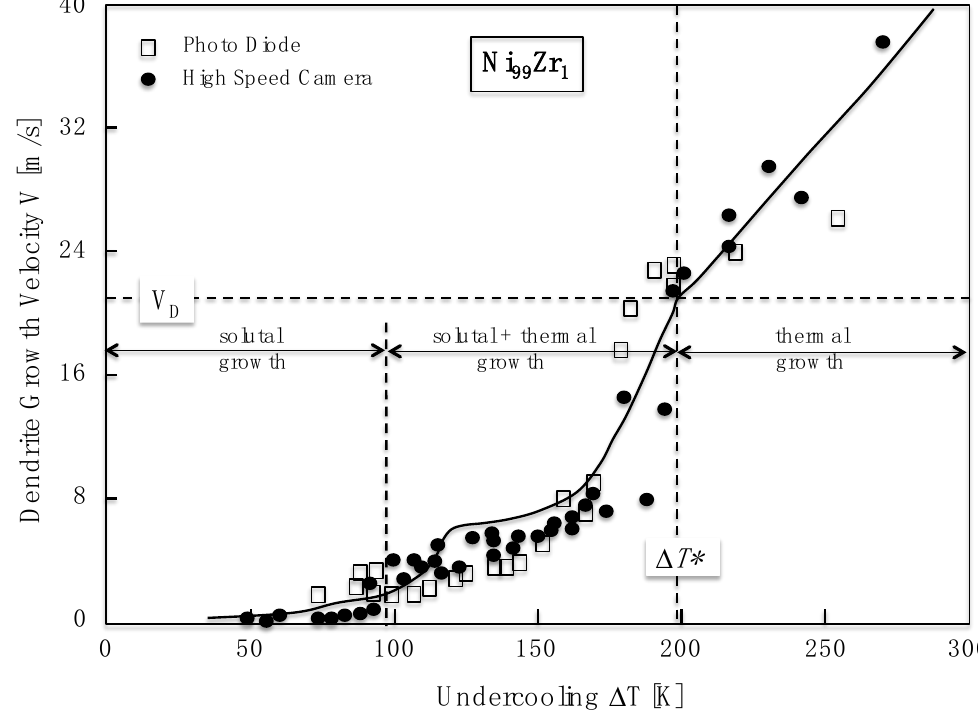
Figure 9. Theoretical predictions (solid line) of the dendrite growth velocity V vs. the undercooling ∆ T in comparison with (i) measurements using the Photo Diode technique (open squares) and with (ii) measurements using a High Speed Camera system (solid circles) for the dilute Ni Zr alloy. At a critical point ∆ T ( V = V ) = ∆ T * = 198 K, a transition from 99 1 D solutal and thermal growth to purely thermally controlled growth occurs and diffusion-less solidification begins to proceed at ∆ T ( V ≥ V ) ≥ ∆ T D